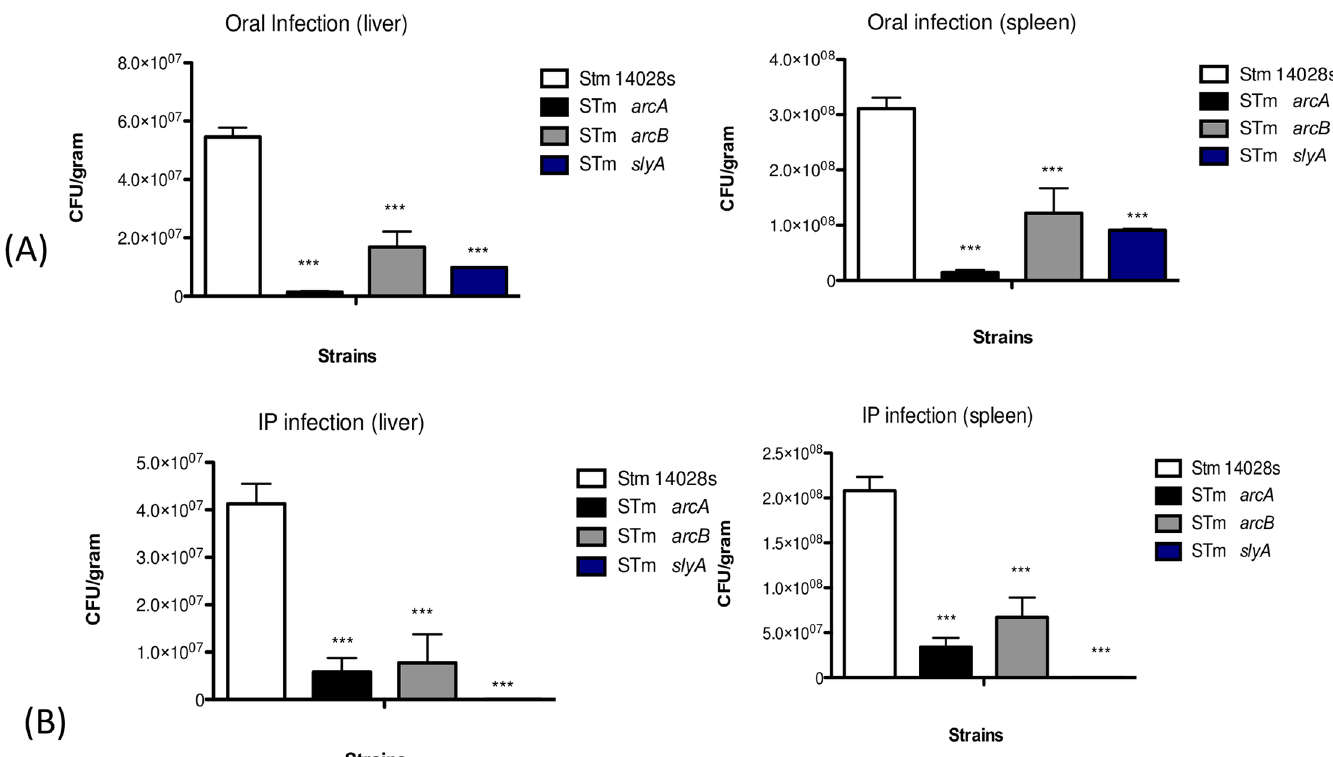
Fig 7. Recovery of Salmonella in C57BL/6 mice. (A) Mice orally infected with 1 × 10 5 bacteria/100 μ l S . Typhimurium 14028s. (B) Mice intraperitoneally infected with 1 × 10 3 bacteria/100 μ l S . Typhimurium 14028s. Δ arc A and Δ arc B strains were grown until OD 600 = 0.2 in microaerophilic conditions. One-way ANOVA with the Bonferroni correction. (cid:3) P < 0.05; (cid:3)(cid:3) P < 0.01, (cid:3)(cid:3)(cid:3) P < 0.001. Biological replicates n = 5, five technical replicates per experiment.